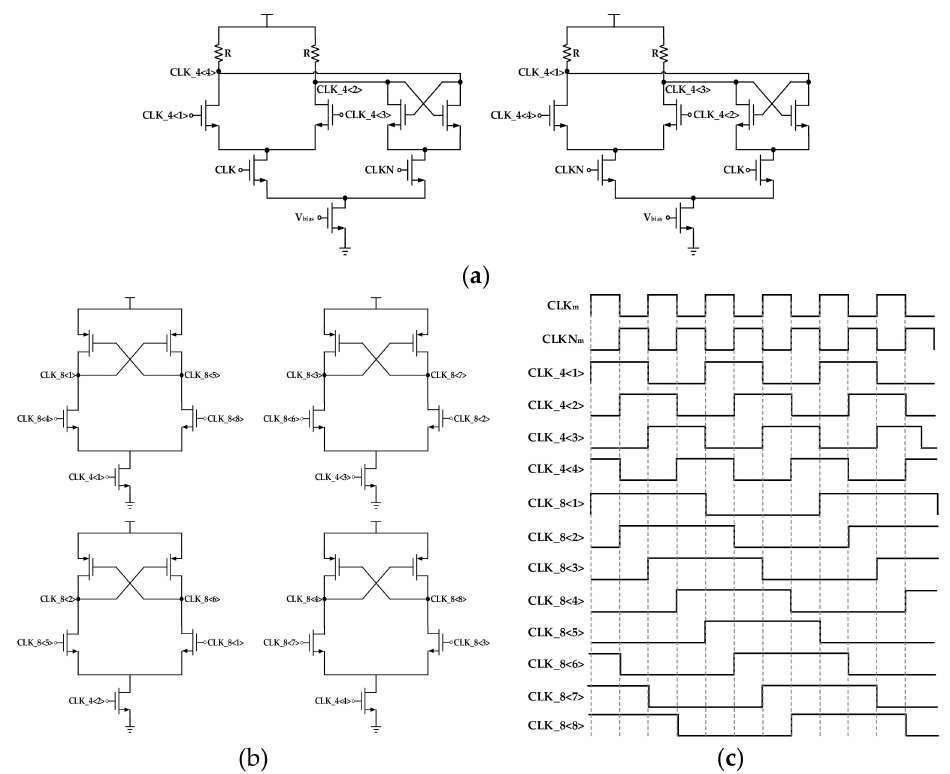
Figure 11. ( a ) The schematic diagram of the CML frequency-dividing circuit, ( b ) the second-stage frequency-dividing circuit and ( c ) voltage waveform of each node in the frequency-dividing circuit. CLK_8 < 1:8 > is a 4.5 GHz clock signal with a 50% duty cycle, which is used as the clock drive